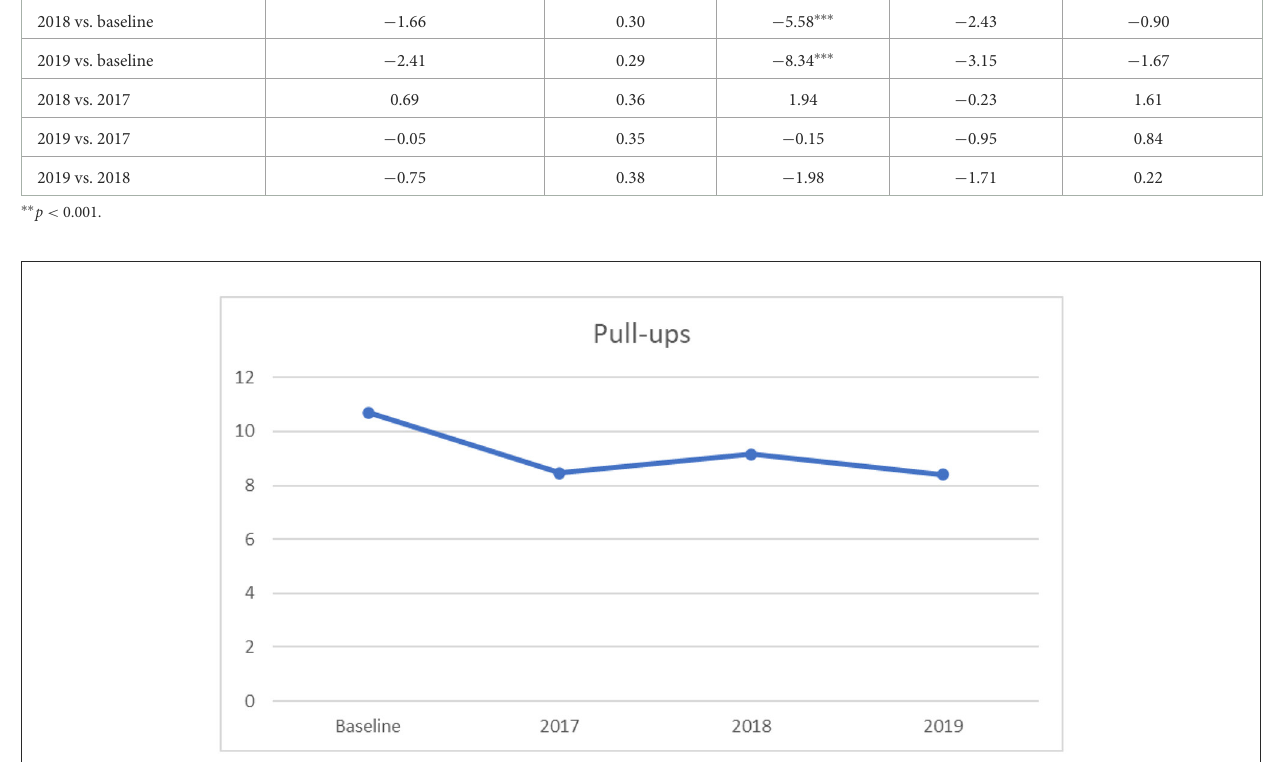
FIGURE6 Mean pull-ups scores: across baseline and years